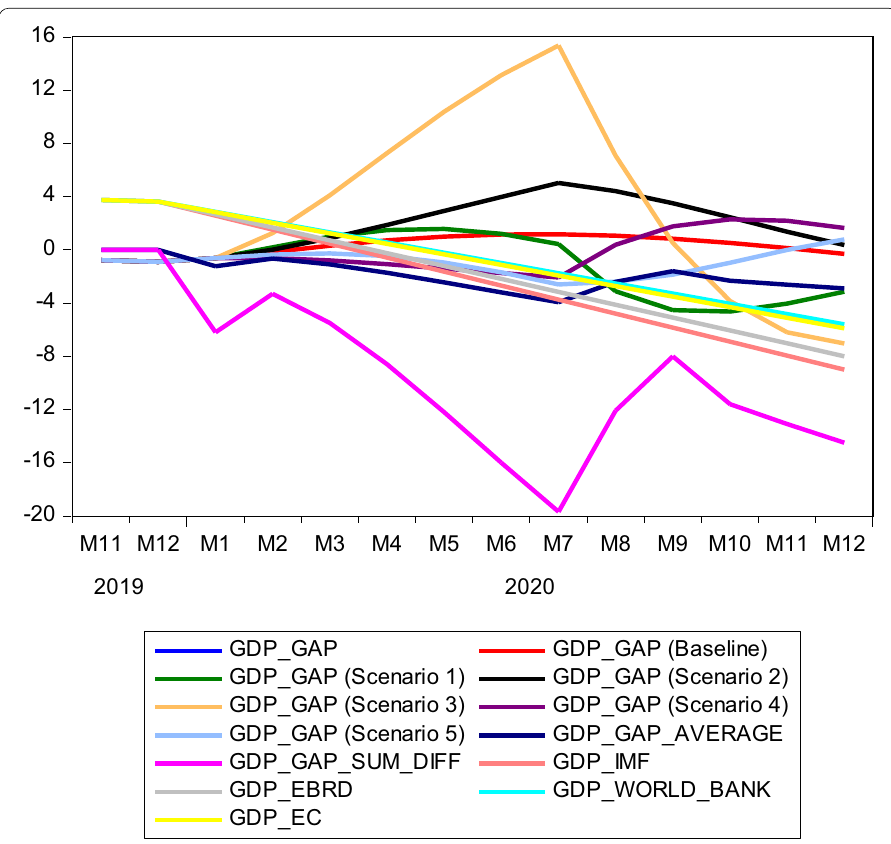
Fig. 4 Bayesian VARX Litterman/Minnesota prior type forecasting GDP_GAP and forecast comparison, 2020:1–2020:12. Source : Authors’